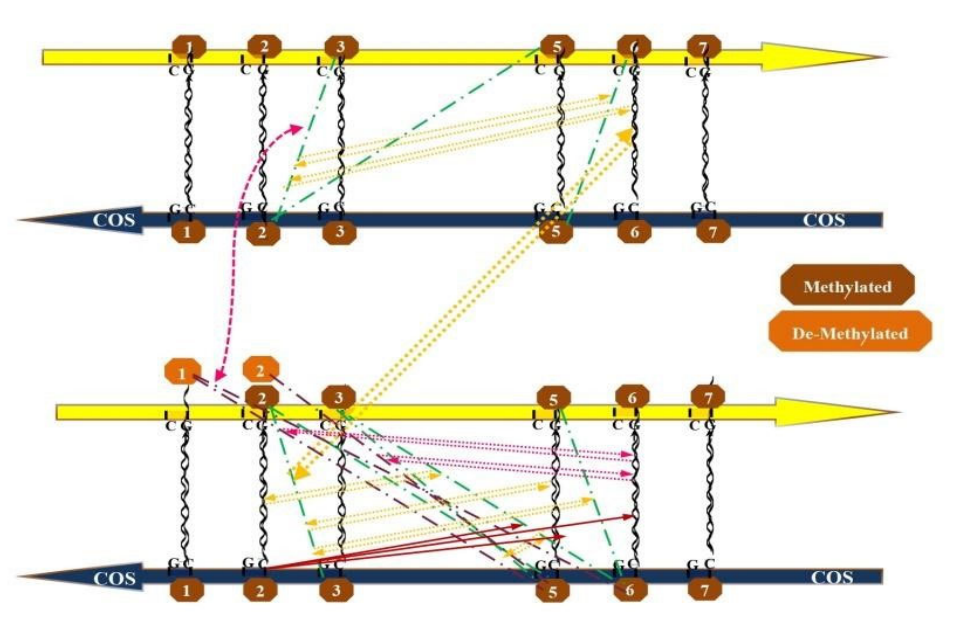
Figure 1. Graphic representation of significant recurrent interactions between certain methylated and sometimes de-methylated CpG pairs, accounting for a tight interaction between cytosines placed one another at their right and giving clues for a leftward slip between the strands (see Figure 4). Each methylated pair is represented by the green point-line-point hatching, the correlations between pairs are drawn by the two-way dashed arrows in yellow. Some main-strand de-methylated \ COS- methylated pairs are represented by the purple point-line-point hatching, the correlations between such pairs and the M6-M6COS pair are drawn by the two-way dashed arrows in purple.